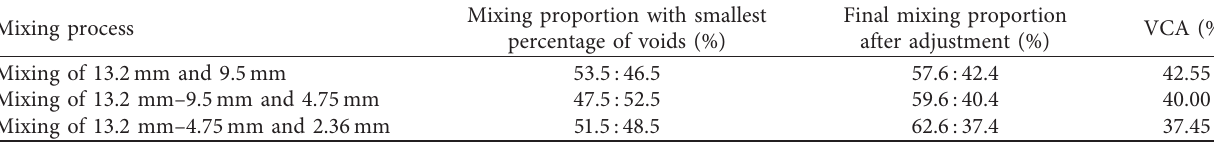
Table 5: Optimal coarse aggregate mixing